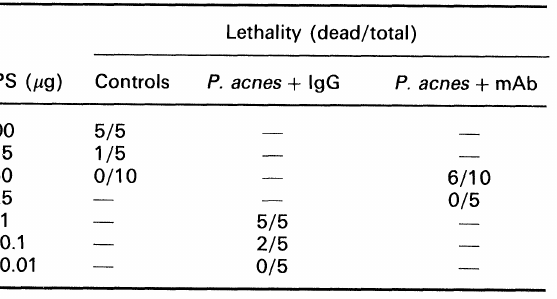
Table 7. Effect of IFN2 antibodies on the P. acnes induced sensitization to LPS